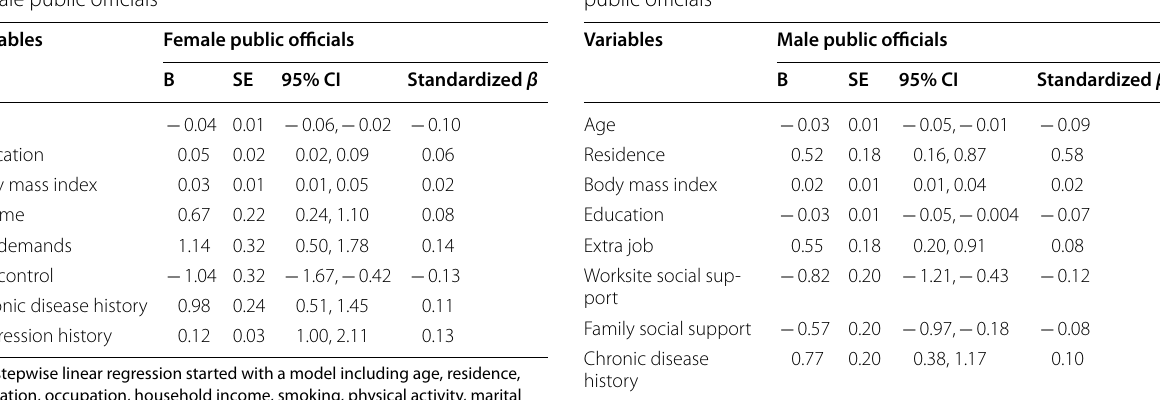
Table 5 Stepwise multiple linear regression for